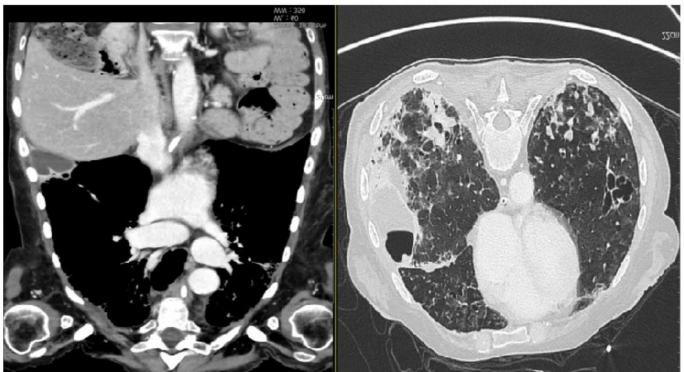
Figure 2. CT scan showing (during hospitalization) pneumonia by Cytomegalovirus. At the lateral- basal segment of the right inferior lobe, in the subpleural level, the gross intraparenchymal collection with hydro-aerial content is compatible with the pneumatocele. In the lung window, multiple areas of parenchymal thickening are visible in the right basal location. (On the left, coronal section parenchymal window, on the right, axial section lung window). Partial laryngectomy (OPHL II B) with bilateral selective neck dissection (cervical nodal Robbins levels II–IV) and postoperative radiotherapy were planned to manage this case. Unfortunately, this planned surgical intervention was impossible because of the patient’s poor general conditions. Moreover, one of the follow-up CT scans of the chest (three months after the initial one) revealed the presence of bilateral diffuse multiple micronodules, which were considered early distant metastasis from the laryngeal adenoid cystic cancer (Figure 3).